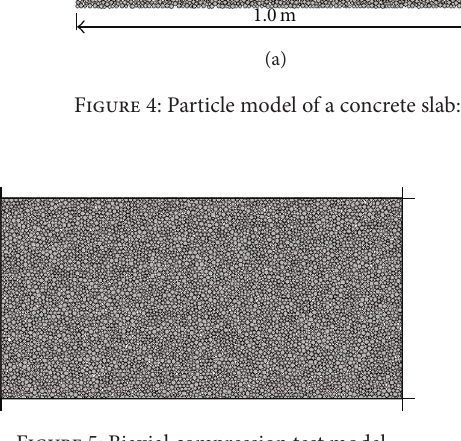
Figure 5: Biaxial compression test model.